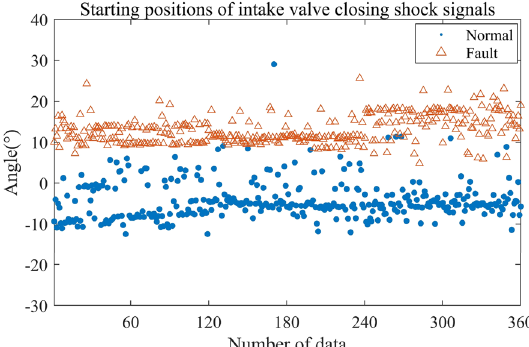
Figure 25 Starting position of intake valve closing shock signal